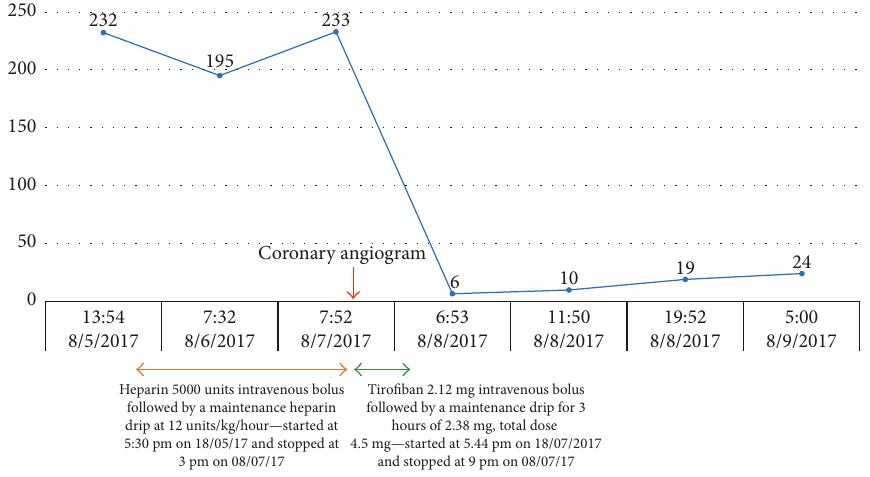
Figure 2: Platelet count in G/L over time with relation to drug exposure. Table 2: The 4Ts score is the sum of the values for each of the 4